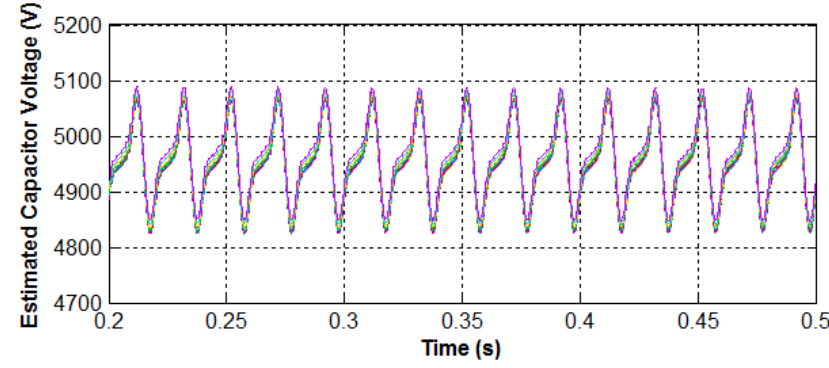
Figure 9. Estimated capacitor voltages in the upper arm of Phase a